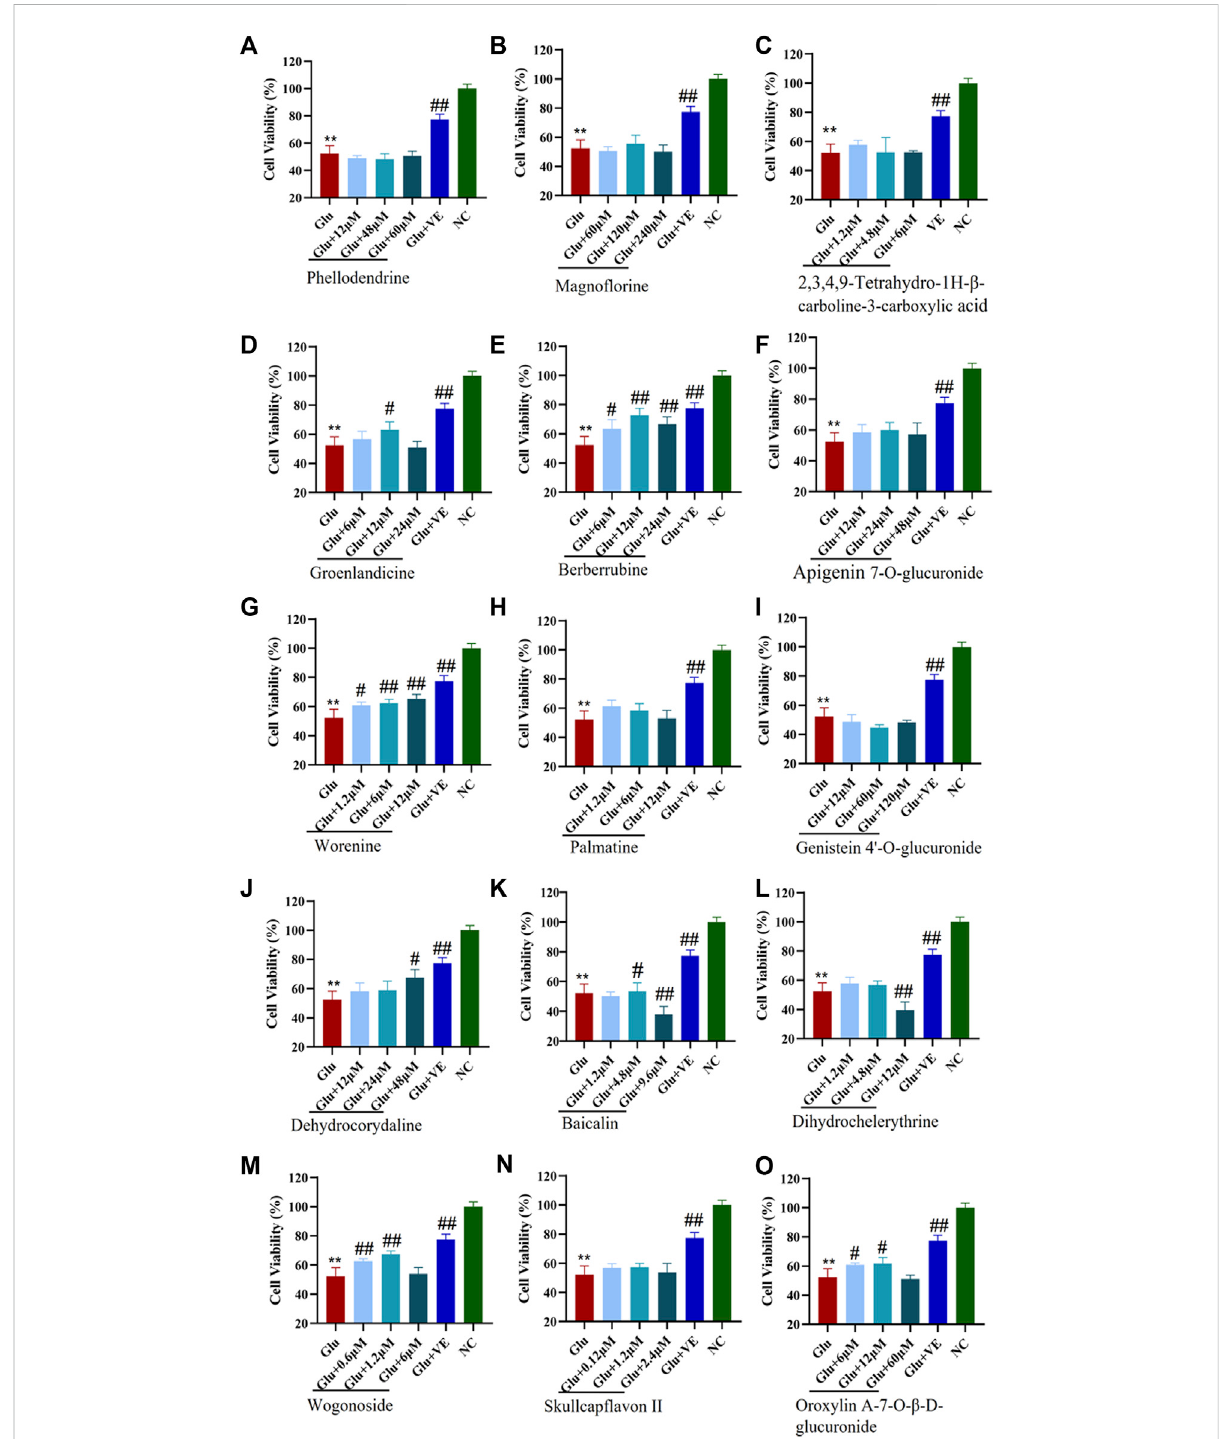
FIGURE 6 Protective effects of CMs@HT22-MB-speci fi c binding components on glutamate-induced toxic damage in HT-22 cells. The CCK-8 kit was used to evaluate the protective effect of compounds against glutamate-induced cell damage in HT-22 cells. The cells were treated with different concentrations of speci fi c binding components or VE (positive control) for 12 h before being exposed to 7 mML-glutamate for 24 h. The medium wasthenreplacedwith100 μ lserum-freeDMEMcontaining10%CCK-8reagent.Thecellswerethenincubatedat37 ° Cfor2 h.Theabsorbance of each well was measured at 450 nm with a microplate reader. (A) phellodendrine; (B) magno fl orine; (C) 2,3,4,9-tetrahydro-1H- β -carboline-3- carboxylic acid; (D) groenlandicine; (E) berberrubine; (F) apigenin 7-O-glucuronide; (G) worenine; (H) palmatine; (I) genistein 4 ’ -O-glucuronide;